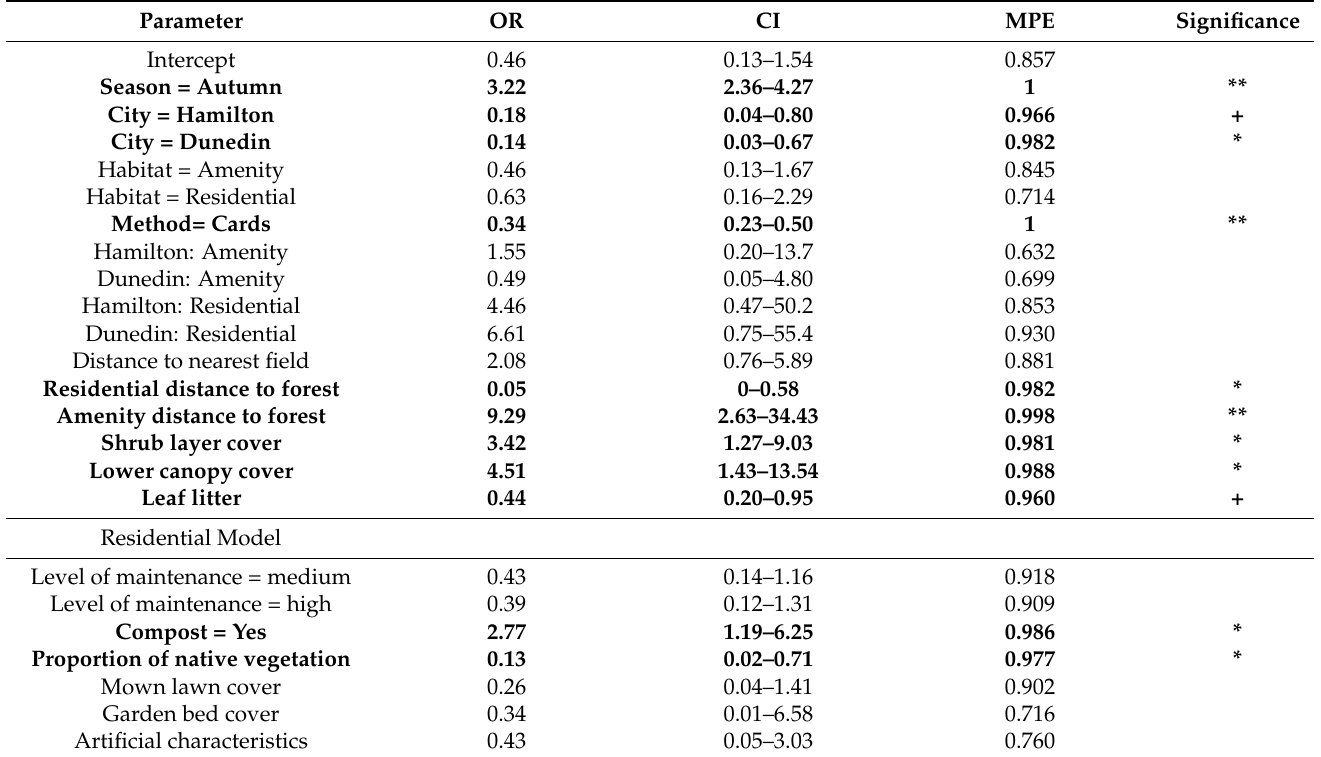
Table 2. Rats: summary statistics for coefficients of the parameters in the main rat model and the additional residential model